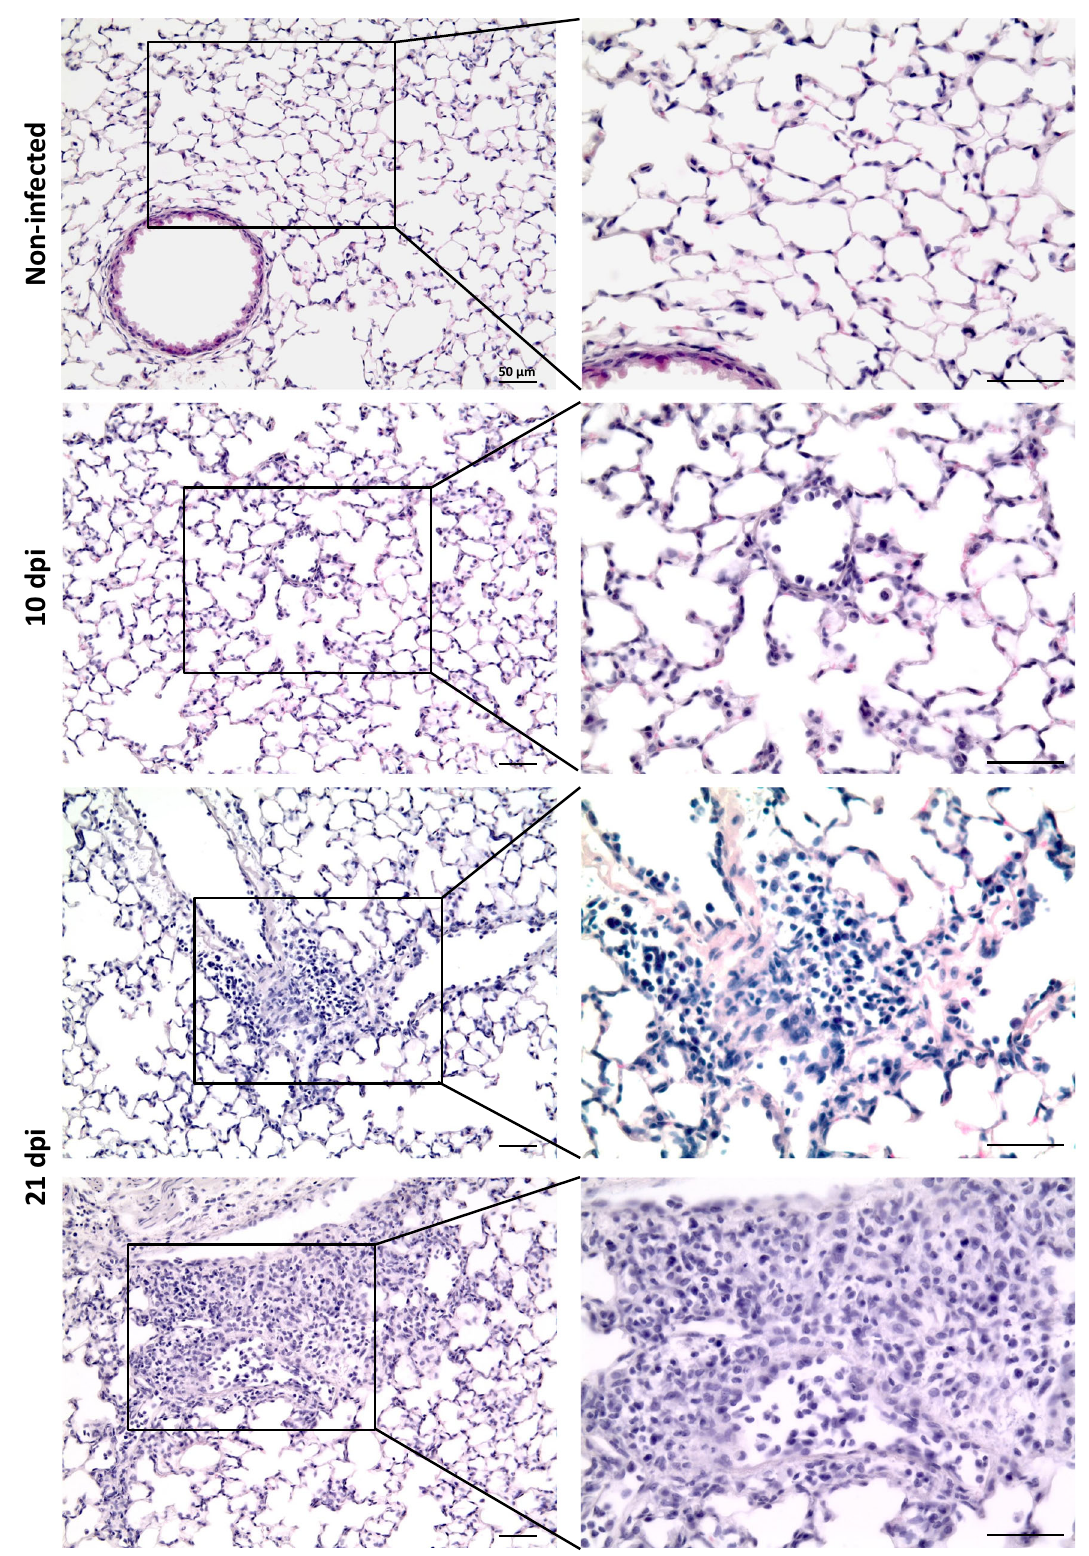
Fig. 3 | Histopathological analysis of lung tissue of T. b. brucei infected mice. Groups of three C57BL/6JRj mice were infected via the bite of a T. b. brucei AnTar1 infected G.morsitans tsetse fl y.Threemicewereprocessedasnon-infectedcontrol. After perfusion of the vascular system and fi xation of the lungs via intratracheal